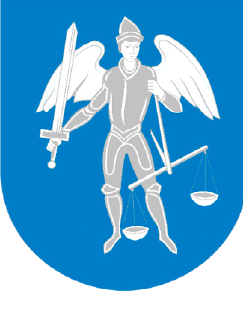
Figure 15. The former arms of